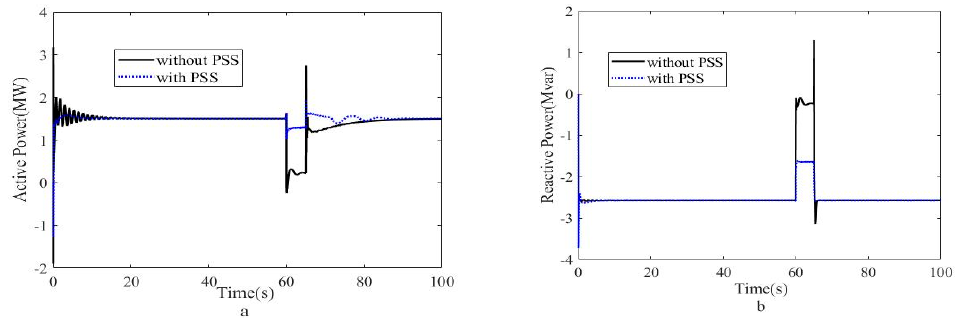
Figure 18 . ( a ) Active power and ( b ) reactive power with and without PSS during three ‐ phase fault condition.